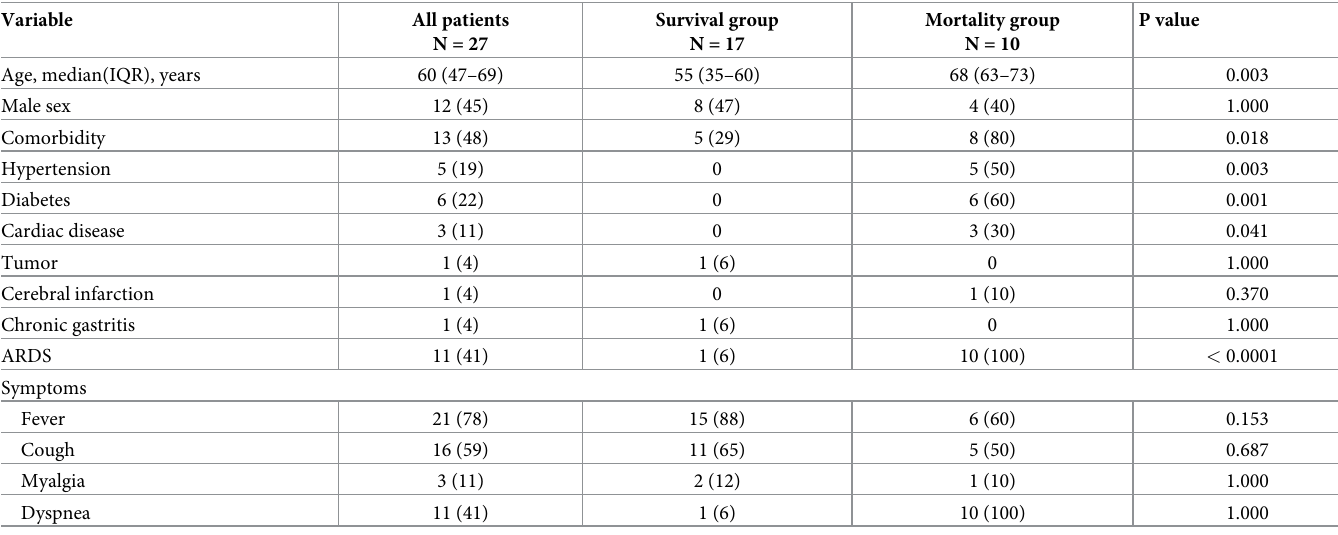
Percentages are in parentheses, unless indicated as median (interquartile range,